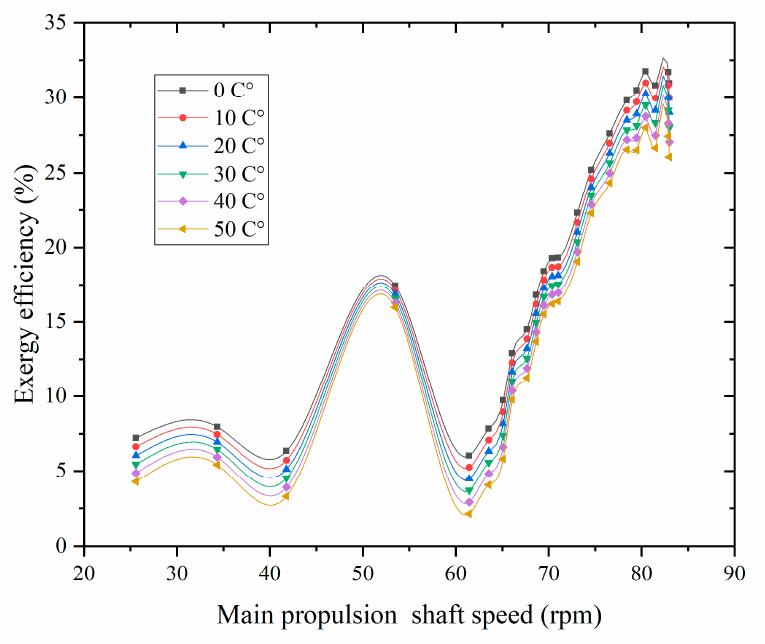
Figure 10. Exergy e ffi ciency with surrounding temperature Figure 10. Exergy efficiency with surrounding temperature change.